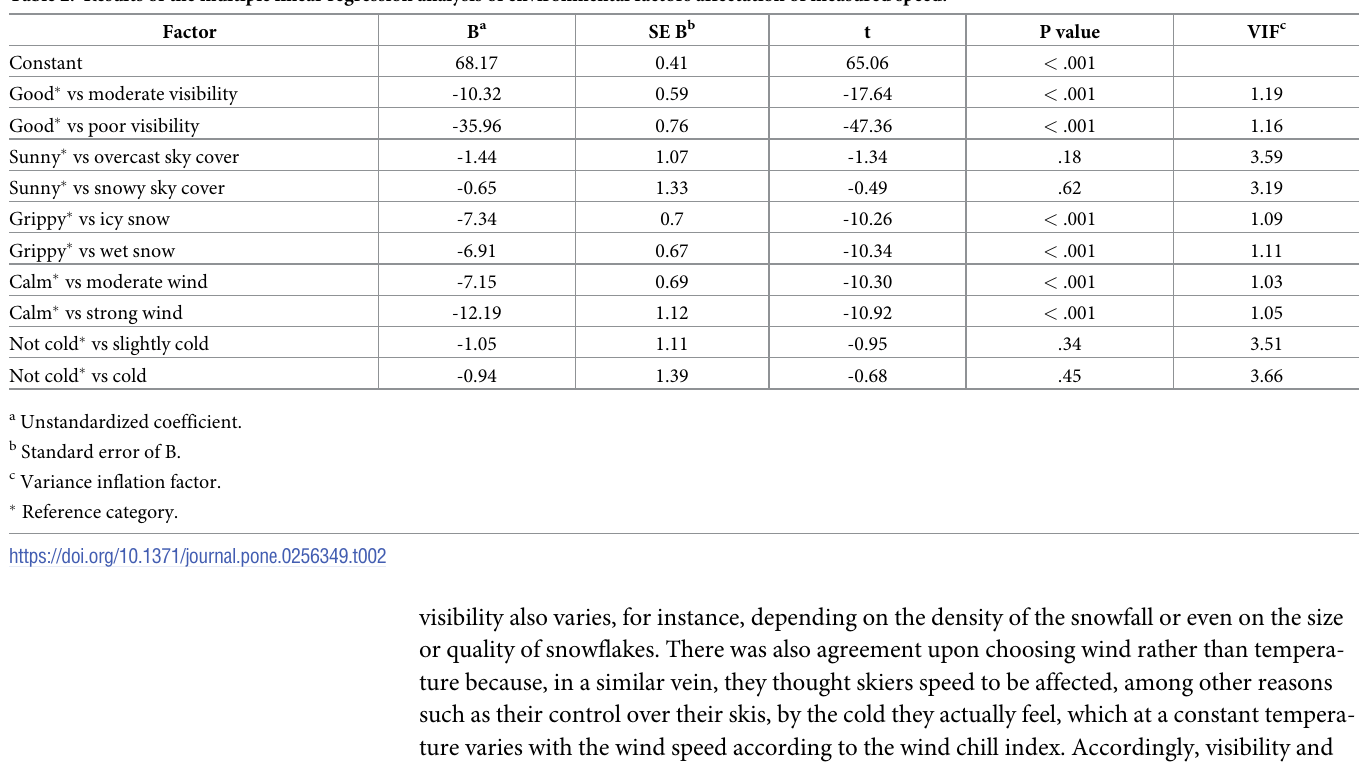
Table 2. Results of the multiple linear regression analysis of environmental factors affectation of measured speed.